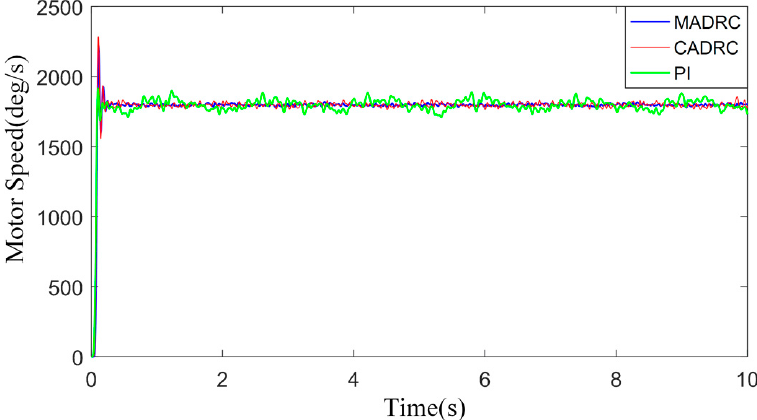
Figure 20. Speed loop step response curves.